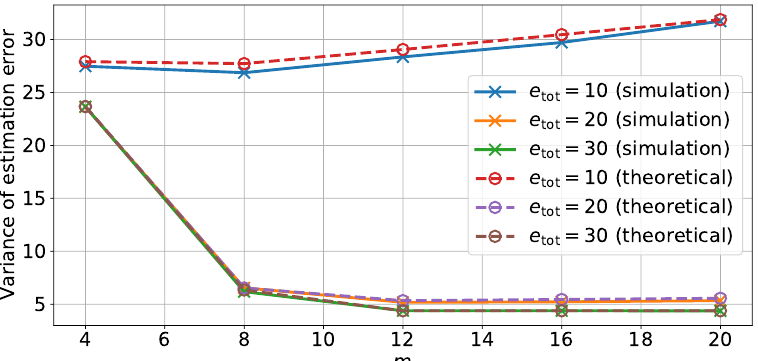
Figure 3. Theoretical and simulated variance of estimation error on the position depending on the number of quantization bits using an unreliable memory for different for different total energy values e tot .